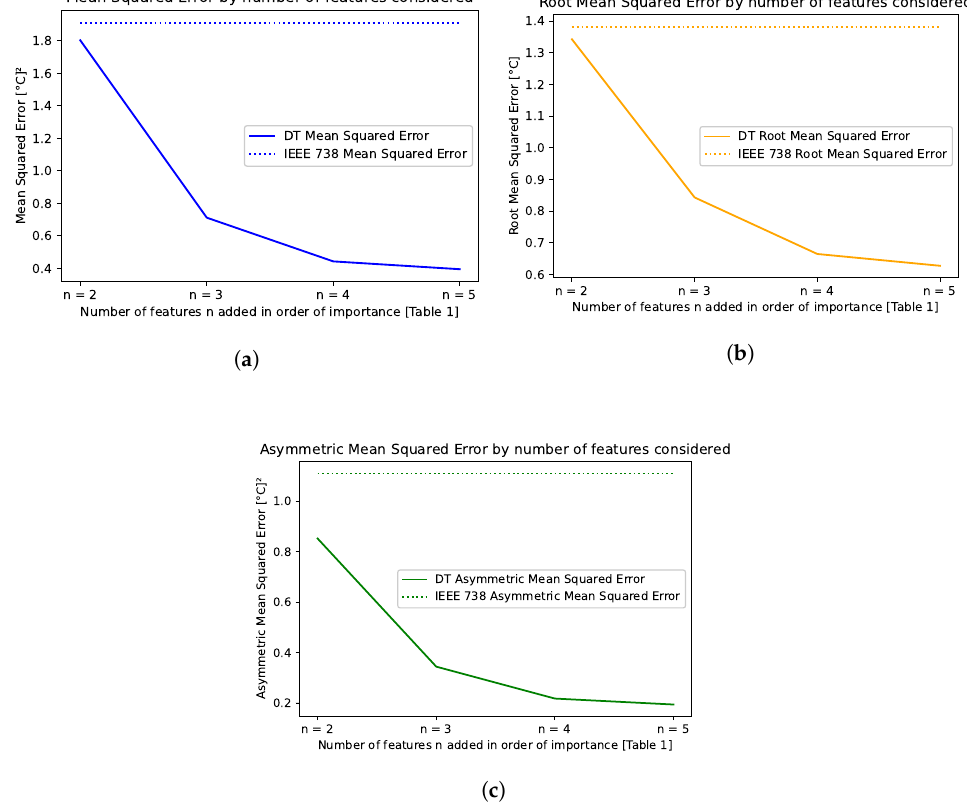
Figure 6. Variation of the error metrics by increasing the dimensionality of the problem. n indicates the number of features considered, in order of decreasing importance as shown in Table 1. ( a ) rep- resents the Mean Squared Error, ( b ) the Root Mean Squared Error and ( c ) the Asymmetric Mean Squared Error, defined in Section 3.3. It is noticeable that the three most important features (air temperature, sun irradiance, and current flow) already allow to obtain an RMSE of less than 1 °C. In the plot, IEEE 738 is constant because it does not depend on external features.